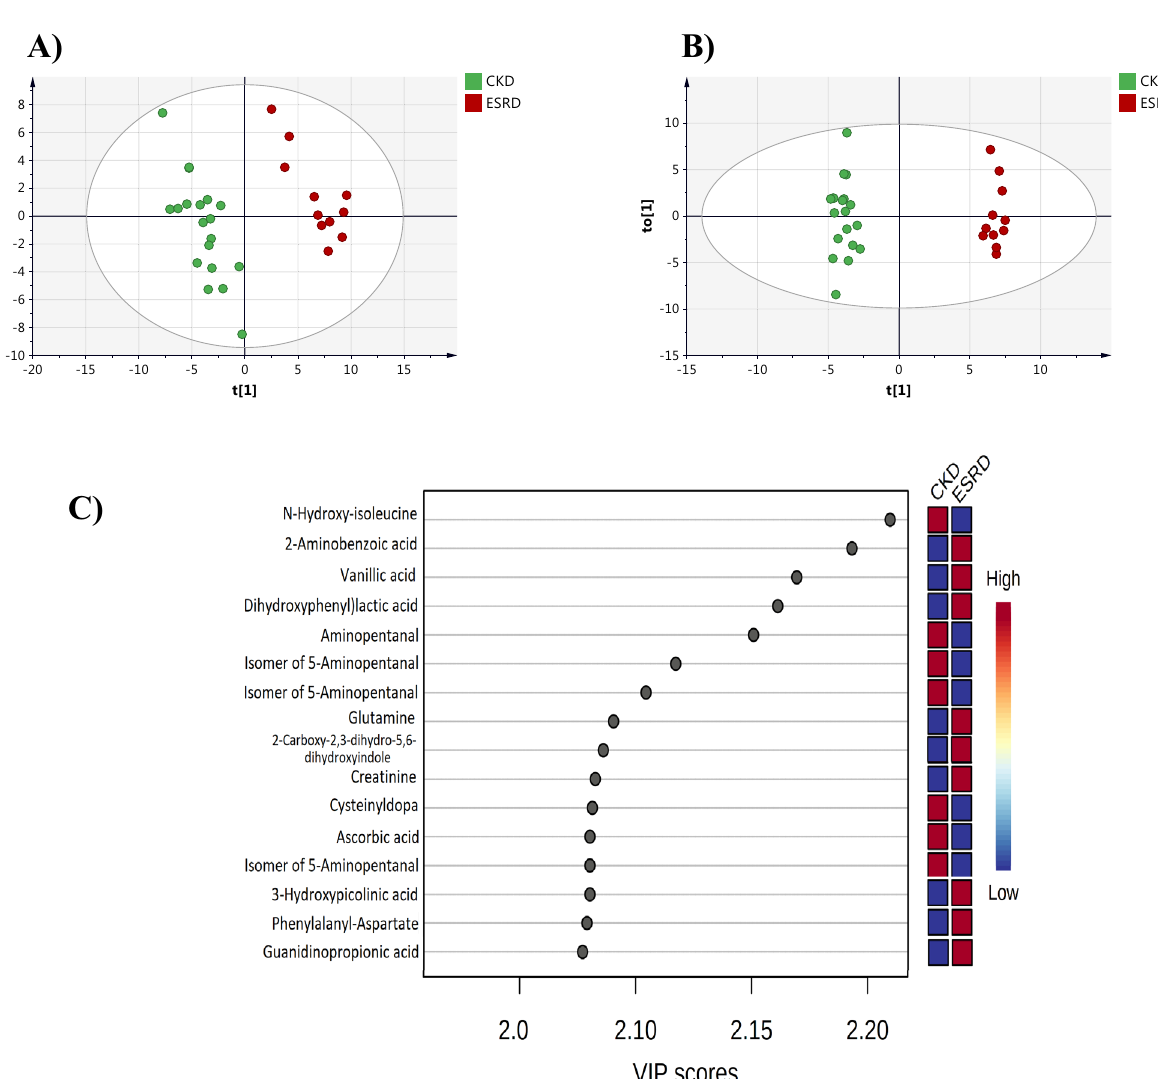
Figure 3. ( A ) PLS-DA scores plot (R2X: 0.54, R2Y:0.99, Q2 0.87). ( B ) OPLS-DA scores plot (R2X: 0.54, R2Y:0.99, Q2: 0.87) of CKD and ESRD groups. ( C ) Metabolites with the highest VIP scores in OPLS-DA